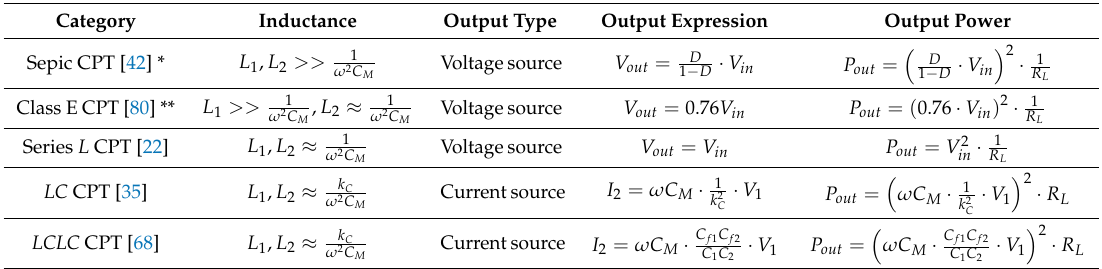
Table 1. Comparison of different compensation circuits.